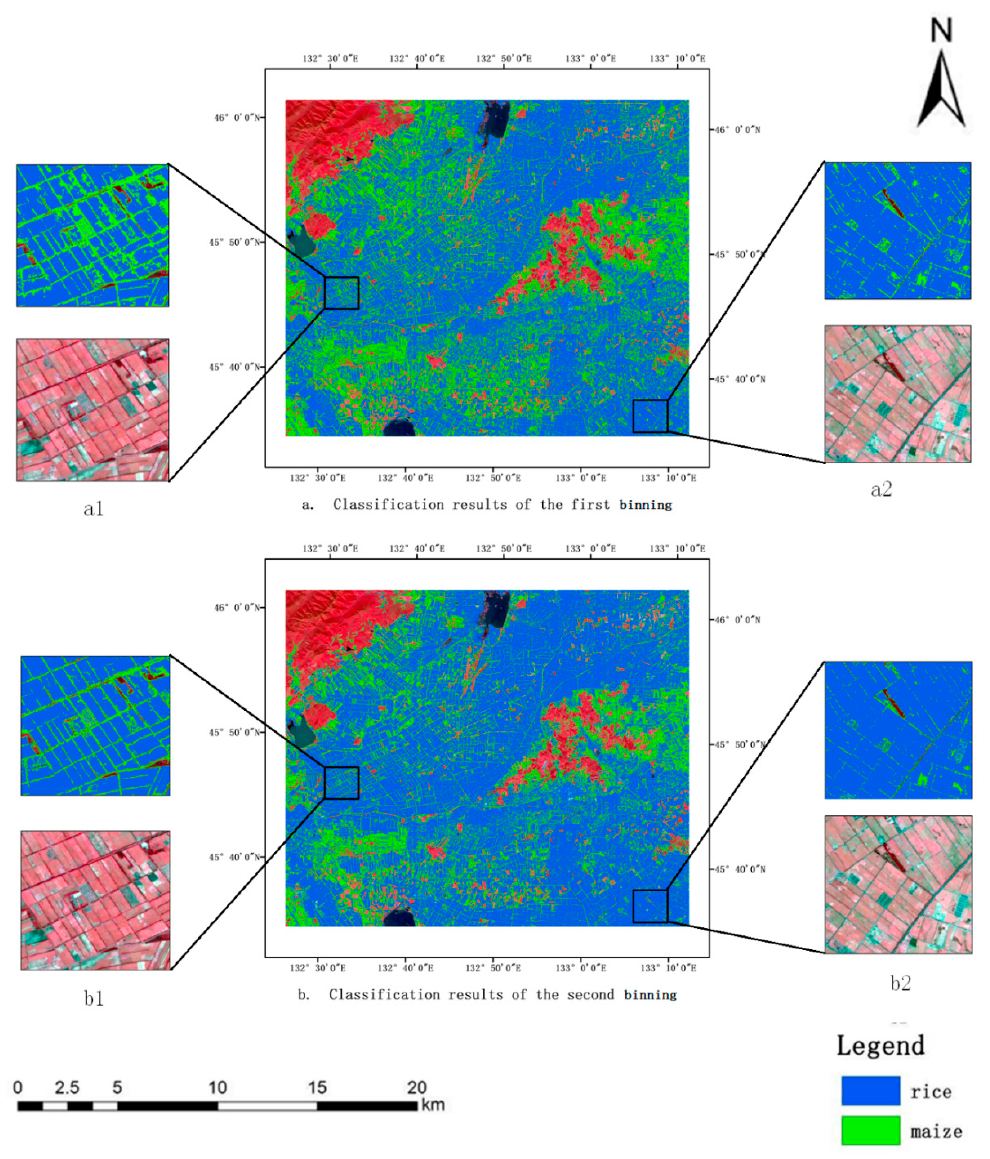
Figure 7. PCIB classification mapping results for southwest of Hulin City in 2016.